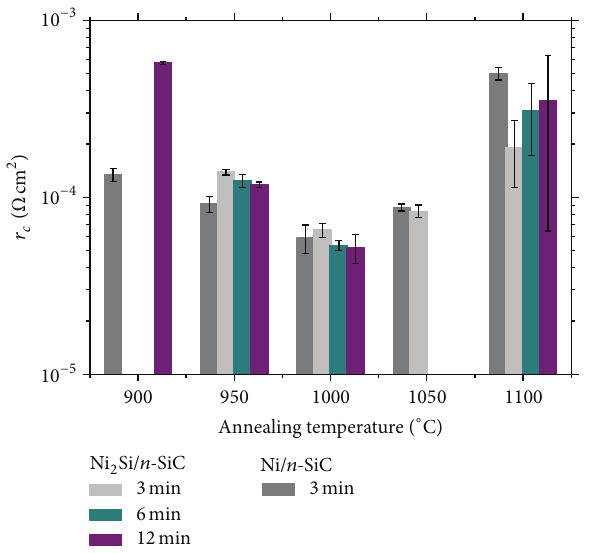
Figure 10: Specific contact resistances ( 𝑟 𝑐 ) of Ni and Ni 2 Si ohmic contacts to n -type ( ∼ 1 × 10 19 cm −3 ) 4H-SiC epiwafers versus anneal- ing temperature/time.